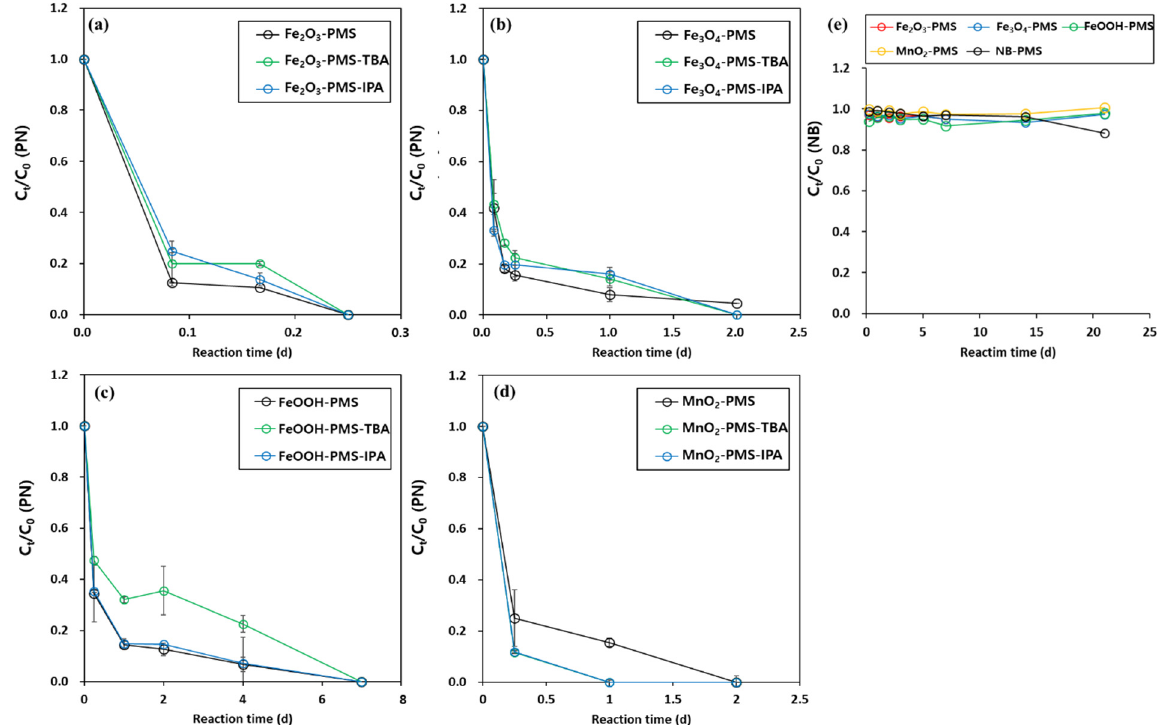
Figure 4. Quenching experiments to identify the reactive species in PN decomposition by PMS oxidant in the presence of diverse metal oxides ( a ) Fe 2 O 3 metal oxide, ( b ) Fe 3 O 4 , ( c ) FeOOH, ( d ) MnO 2 , and ( e ) NB decomposition by different metal oxide-PMS oxidant ([PN] = 20 µM, [PMS] = 200 µM, [metal oxide] = 0.1 g/L, [borate buffer solution] = 18.75 mM, [pH] = 7.5~8.0, [TBA] = 100 mM, [IPA] = 100 mM, [NB] o = 20 µM).